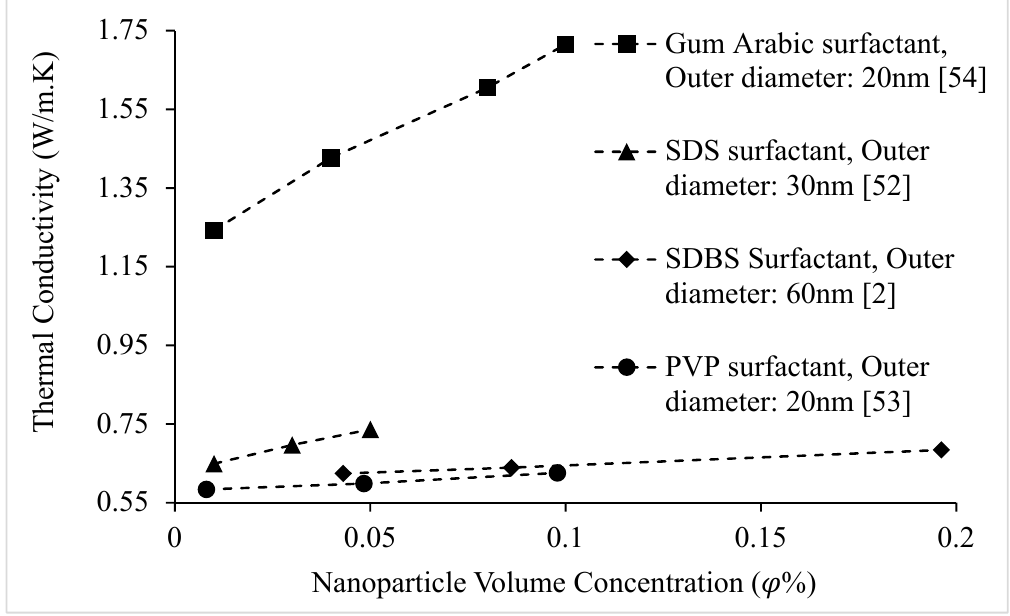
Figure 25. Effect of surfactant on the thermal conductivity of MWCNT–water nanofluid as a function of nanoparticle volume concentration, 𝜑 , at room temperature.